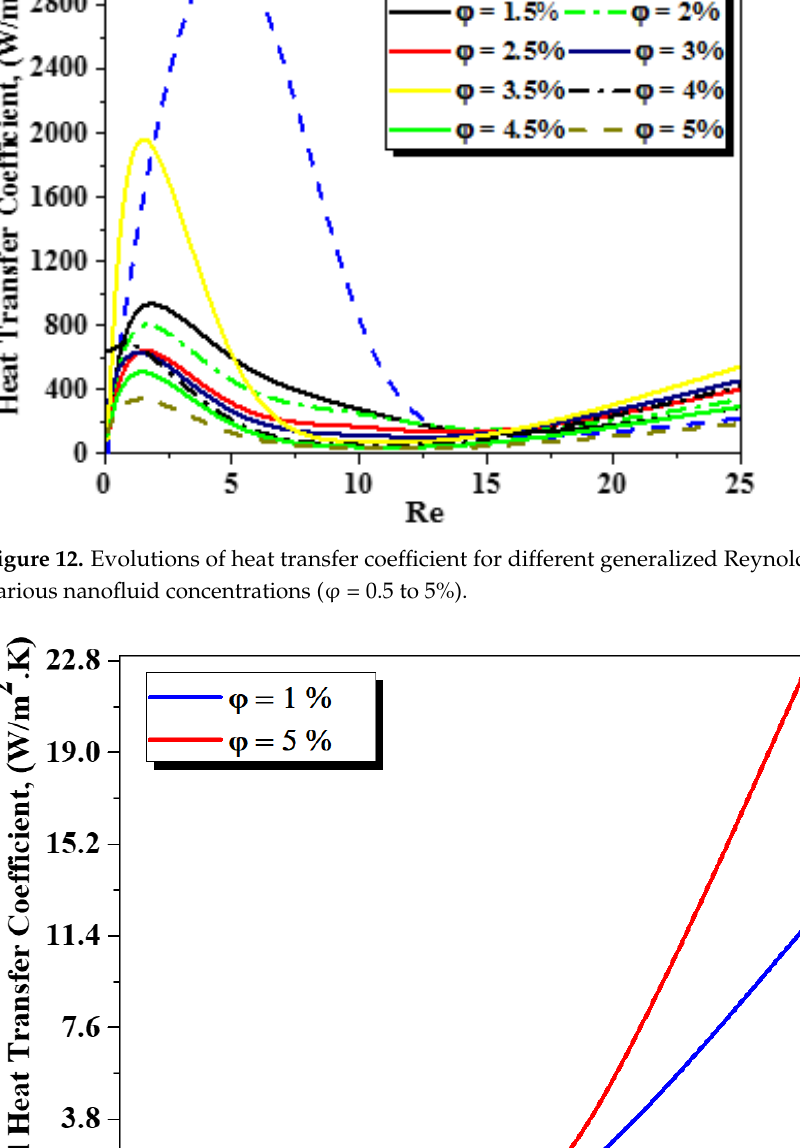
Figure 11. Qualitative representation of Temperature contours for different generalized Reynolds number at the horizontal middle section of each nano-fluid concentrations ( φ = 0.5 to 5%).